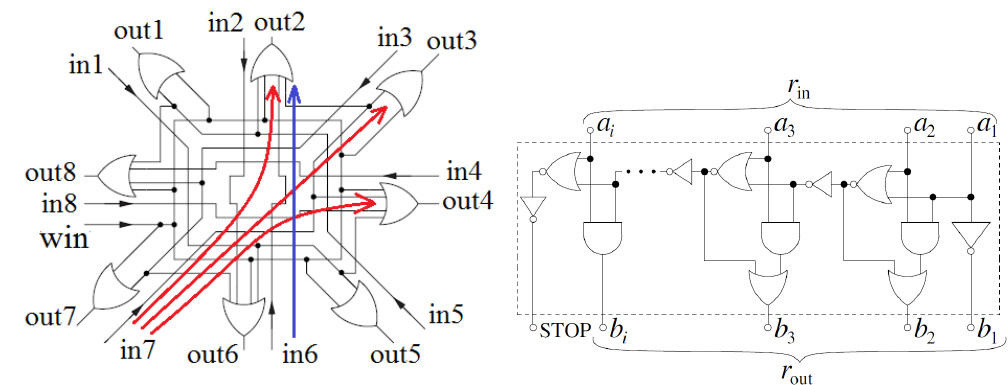
Figure 6. Main components of the neighborhood mechanism used in our former approach